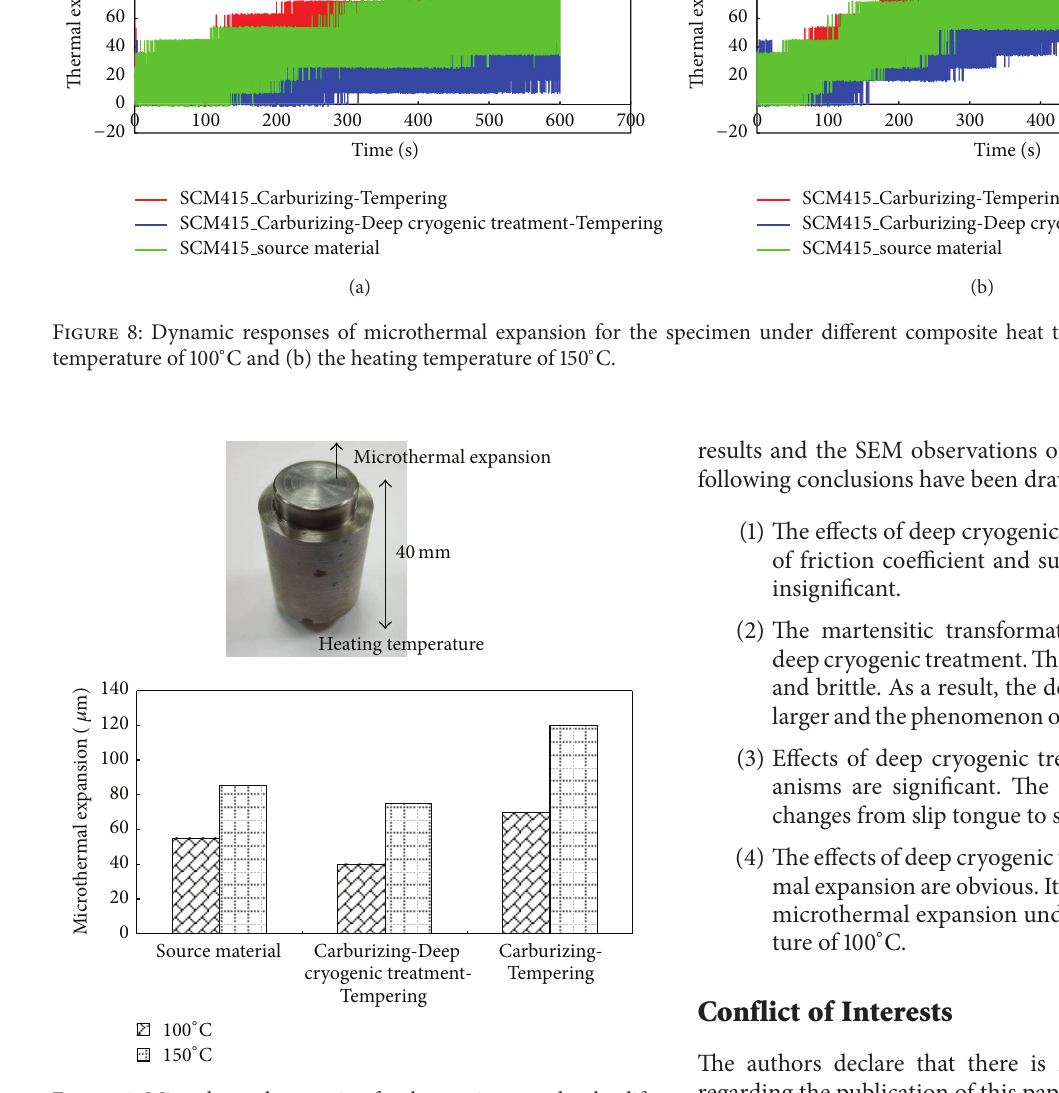
Figure 9: Microthermal expansion for the specimen under the dif- ferent heating